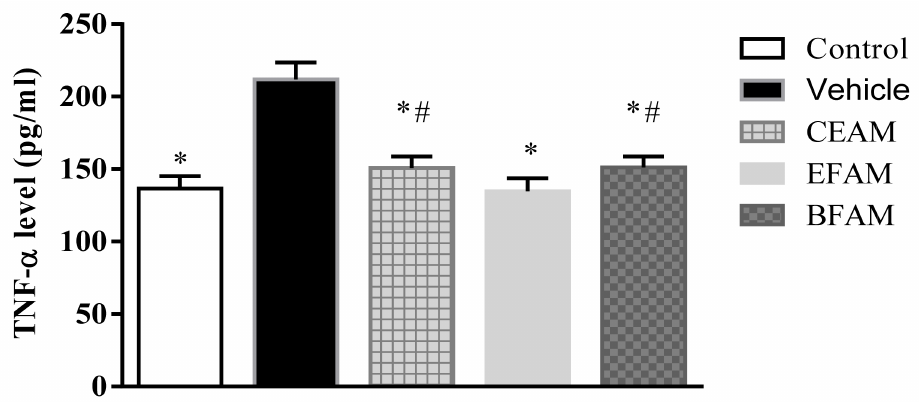
Figure 4. Effect of the A. maurorum extract and fractions on tongue tissue TNF- α level in acetic acid-induced tongue ulcers in rats compared with the vehicle and control rats. * p < 0.0001 vs. vehicle group and # p < 0.05 vs. EFAM group, using One-way ANOVA followed by Tukey–Kramer as a post hoc test. Results are shown as mean ± SD ( n = 6).